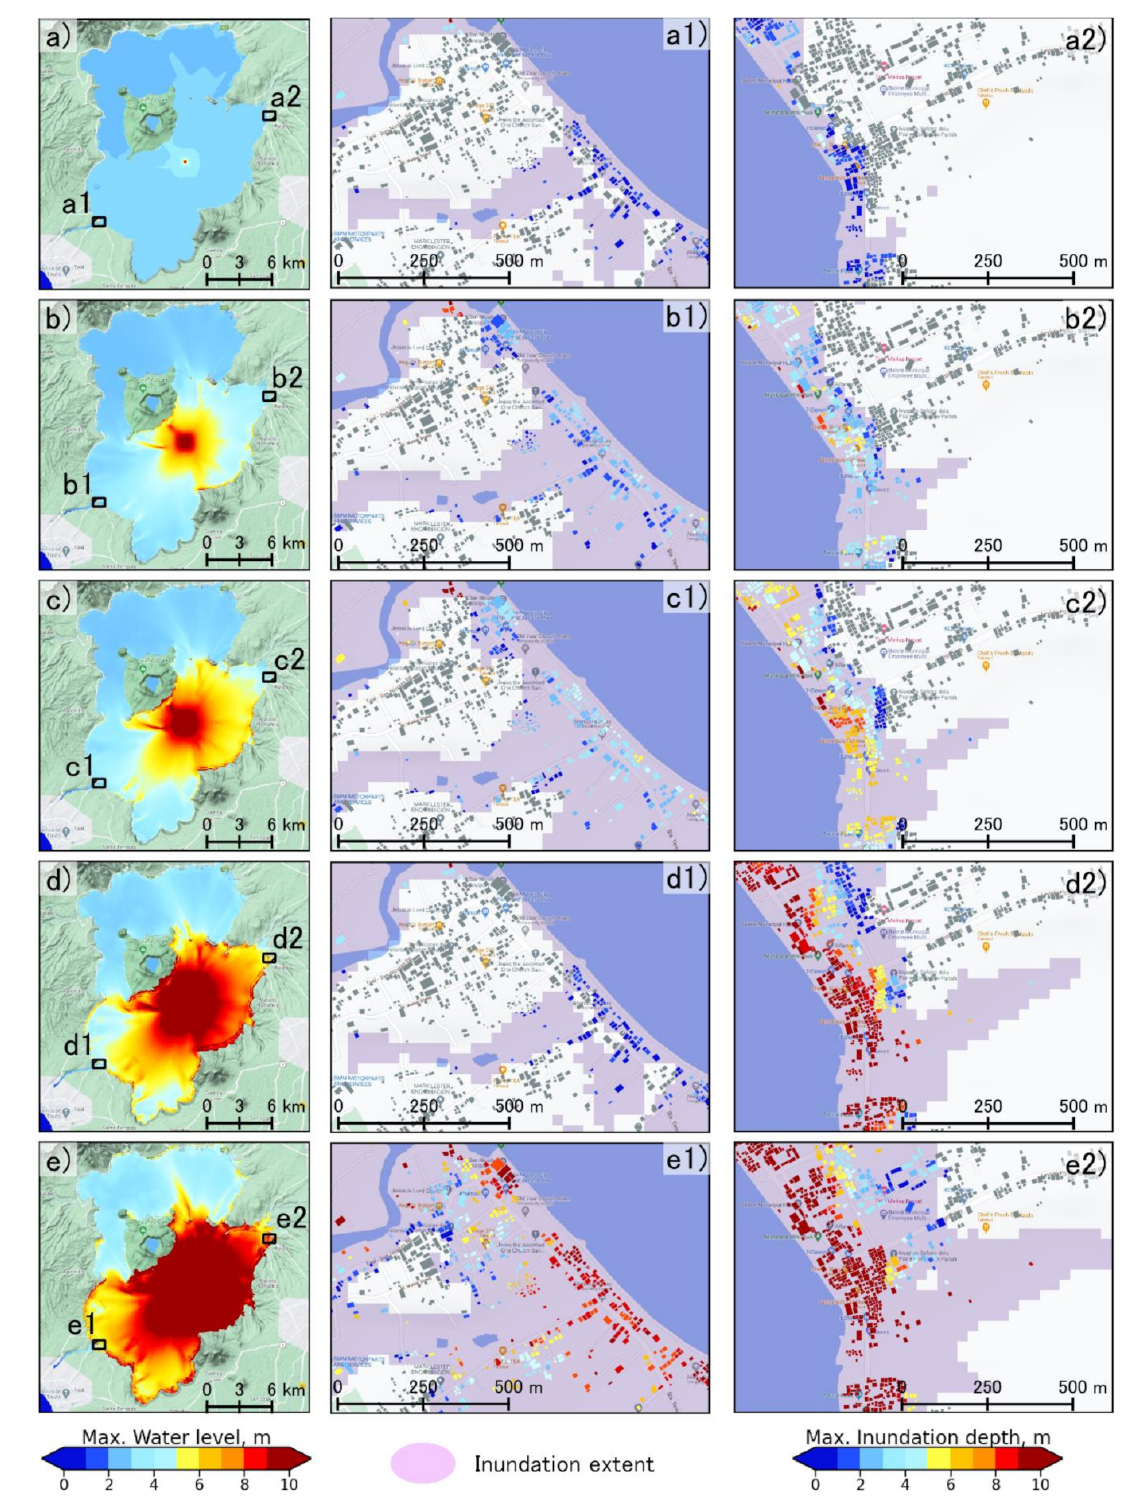
Figure 5. Maximum water level, flooded area, and an overlay on the building to present the inundation depth at building: ( a ) 1st scenario (explosion energy of 0.374 × 10 15 J and associated initial water level of 25.8 m), ( b ) 25th scenario (explosion energy of 1.84 × 10 15 J and associated initial water level of 65.9 m), ( c ) 50th scenario (explosion energy of 4.69 × 10 15 J and associated initial water level of 82.5 m), ( d ) 75th scenario (explosion energy of 14.7 × 10 15 J and associated initial water level of 108.5 m) and ( e ) 99th scenario (explosion energy of 35.6 × 10 15 J and associated initial water level of 134.2